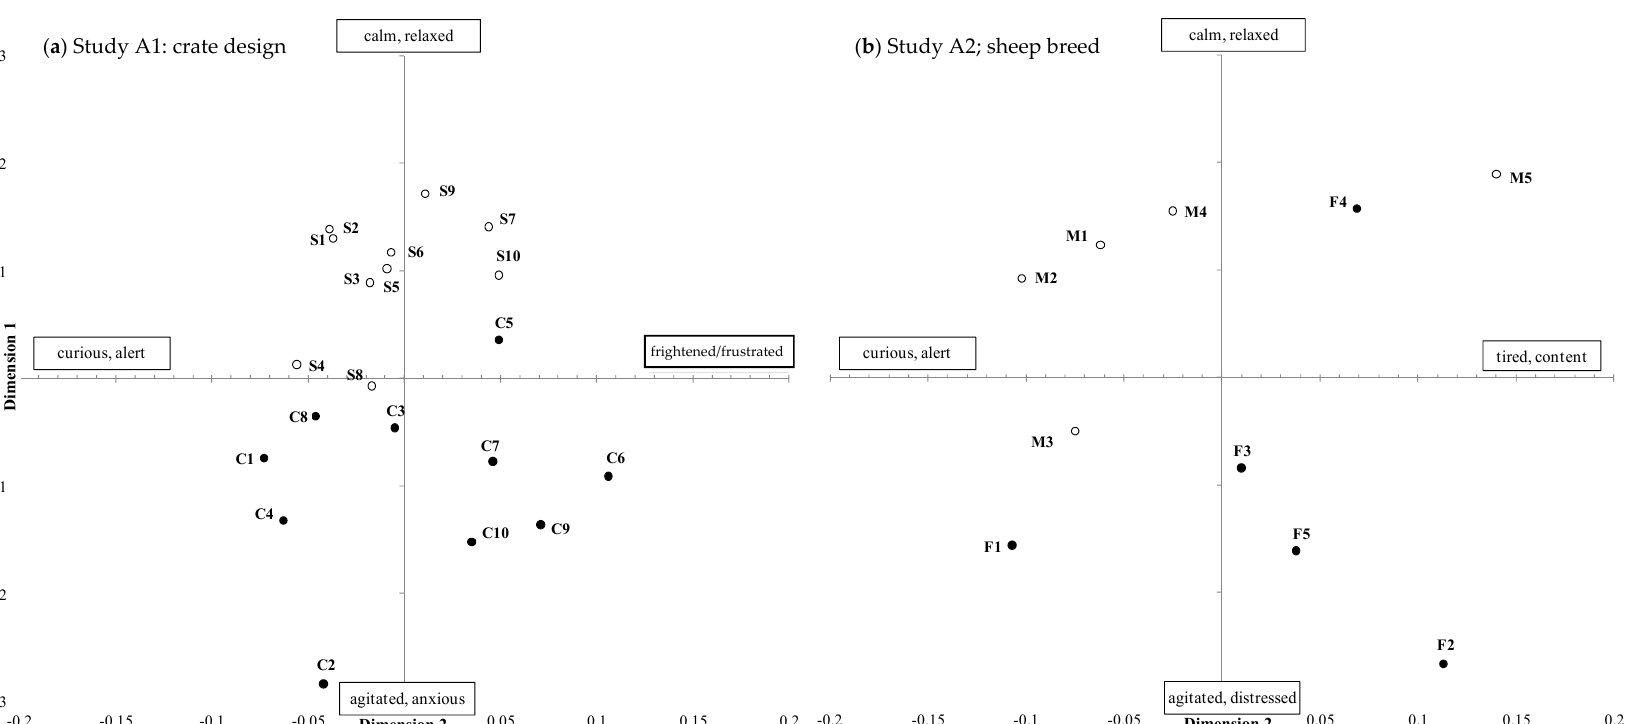
Figure 5. Positions of individual transport clips (represented by numbers) on Generalised Procrustes Analysis (GPA) dimensions 1 (y axes) and 2 (x axes). ( a ) Study A1: crate design experiment (S: standard crate, open circles, or C: convertible crate, closed circles); ( b ) Study A2: sheep type experiment (M: Merino sheep, open circles, or F: Fat-tail sheep, closed circles). Bold text indicates GPA dimensions 1 for both studies were statistically significantly different between treatments.